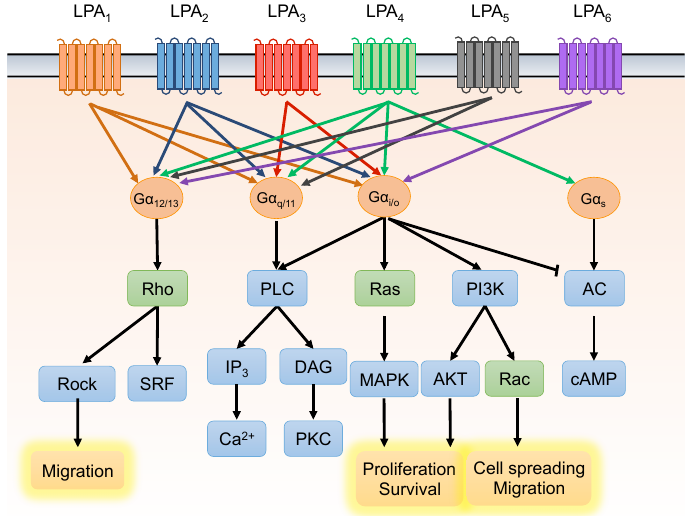
Figure 2. Lysophosphatidic acid (LPA) receptors and downstream signaling pathways. LPA binds LPA receptors (LPA 1–6 ) with varying affinities, triggering various downstream signaling cascades via receptor coupling to four different heterotrimeric G proteins. Through this signaling mechanism, LPA mediates cellular events such as cell proliferation, apoptosis, migration, and